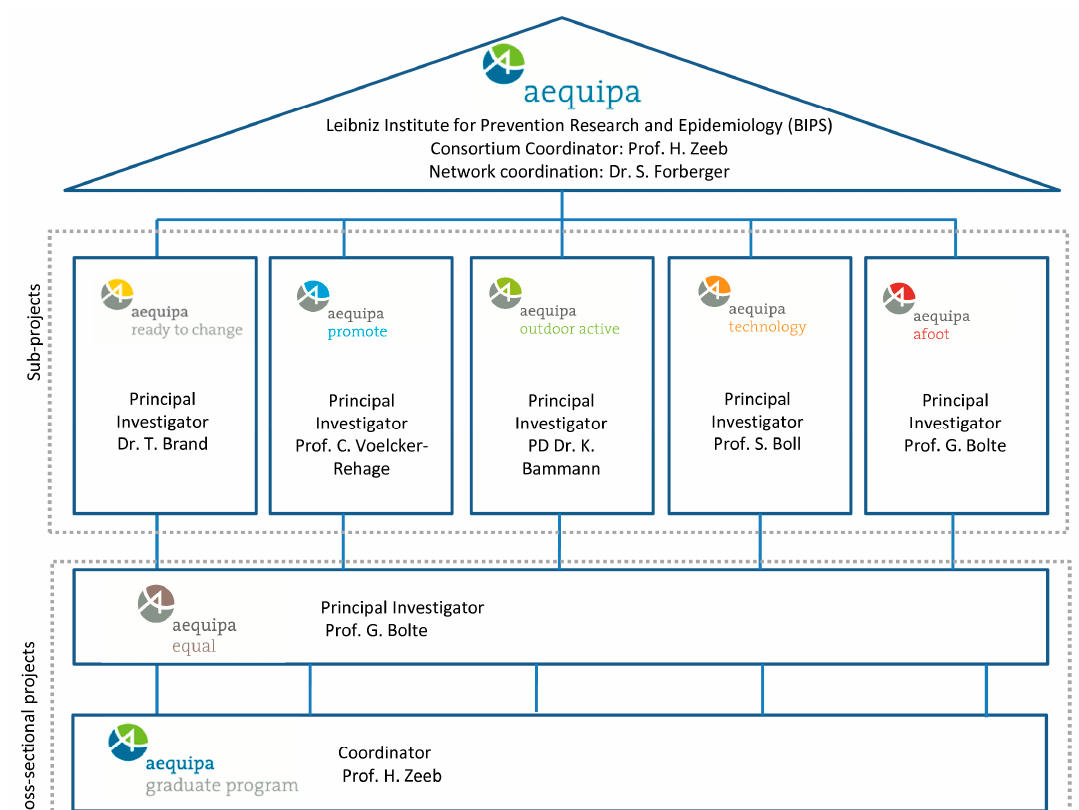
Figure 1. AEQUIPA 1 network structure.